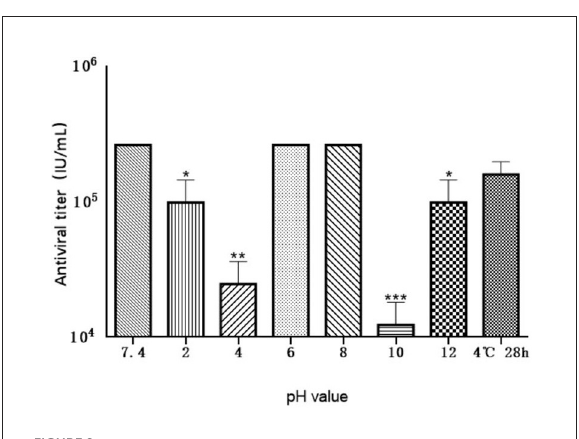
FIGURE9 Effect of various pH levels on the antiviral activity of MiIFN- α . Antiviral activity of mink IFN- α in a F81/VSV system treated at 4 ◦ C for 24h at pH 2, 4, 6, 7.4, 8, 10, 12, and for 28h at pH 7.4; p < 0.01. *, P ≤ 0.05 ; **, P ≤ 0.01; ***, P ≤